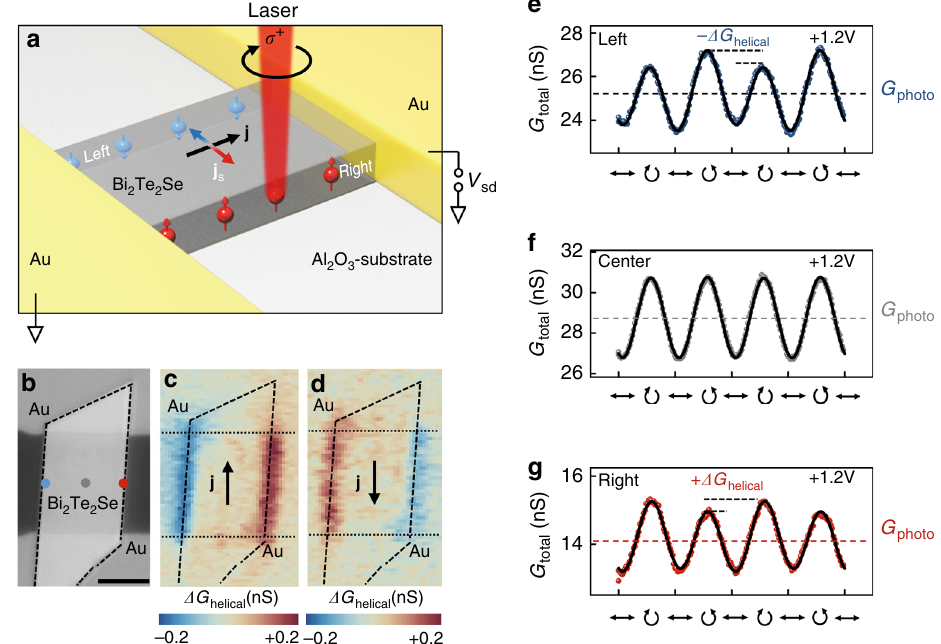
Fig. 1 Helicity-dependent edge conductance at room temperature. a Sketch of a Bi 2 Te 2 Se (BTS) platelet in a metal/topological-insulator/metal geometry excited by circularly polarized light at perpendicular incidence. Red (blue) spheres represent the electron spin polarization on the right (left) facet of the platelet, when a bias voltage V sd is applied between source to drain. Correspondingly, an electron current density j fl ows, which in turn gives rise to a transverse spin current density j s . Under illumination, the helicity of the photon excites spins, which are equally driven into this transverse direction. b Optical microscope image of a BTS platelet (highlighted by dashed lines), contacted by two Ti/Au contacts. Scale bar is 5 µ m. c , d Spatial map of the photoconductance generated by the circularly polarized light at bias voltages of V sd = + 1.2 V and V sd = -1.2 V respectively. We use a photo-elastic modulator detecting the difference Δ G helical = G helical ( σ − ) – G helical ( σ + ) of photoconductance which depends on the circularly left ( σ − ) and right ( σ + ) polarized light. e-g Total photoconductance G total as a function of the laser polarization at the left and right edge, as well as the center [cf. blue, gray, and red dots in b ]. The polarization is controlled by a quarter waveplate. The symbol ↔ denotes linearly polarized, ↻ circularly right polarized light, ↺ circularly left polarized light. All measurements are performed at V sd = + 1.2 V, P laser = 230 µ W, and room